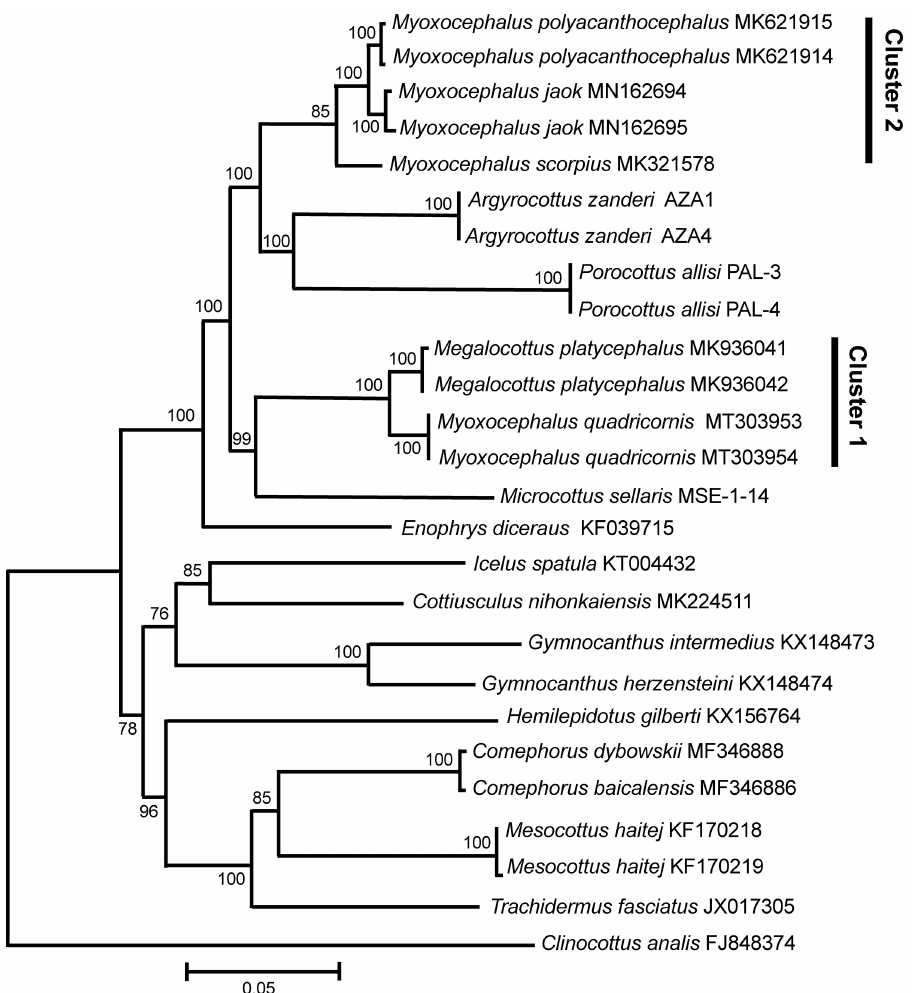
Figure 1. Maximum likelihood tree for the fourhorn sculpin Myoxocephalus quadricornis and members of the family Cottidae from GenBank inferred from the complete mitochondrial genomes. The tree is based on the General Time Reversible + gamma + invariant sites (GTR + G + I) model of nucleotide substitution. The numerals at the nodes are bootstrap percentage probability values based on 1000 replications (values below 75% are omitted).